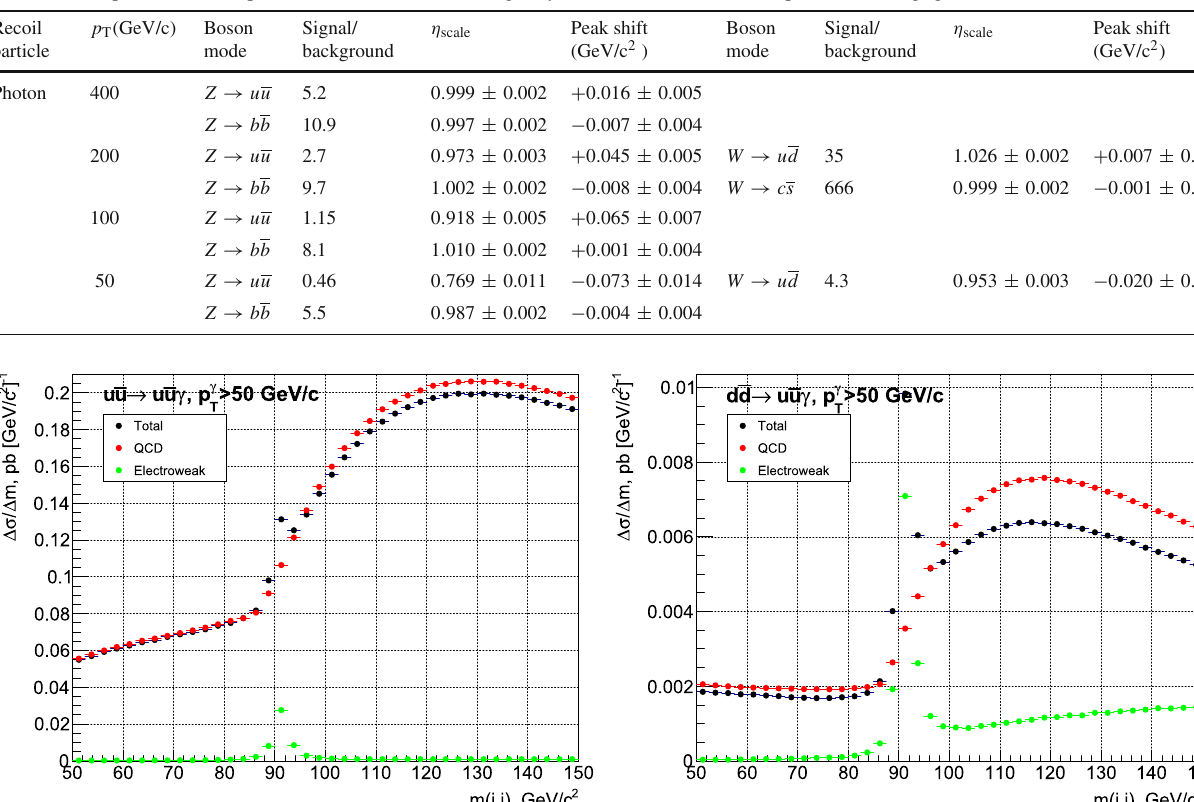
Table 5 Interference effects on the Z and W boson peaks in qq → V γ , separated by final state quark flavour. Signal-to-background is defined at the resonance peak without experimental resolution and using only the initial and final states quoted, with negligible statistical error